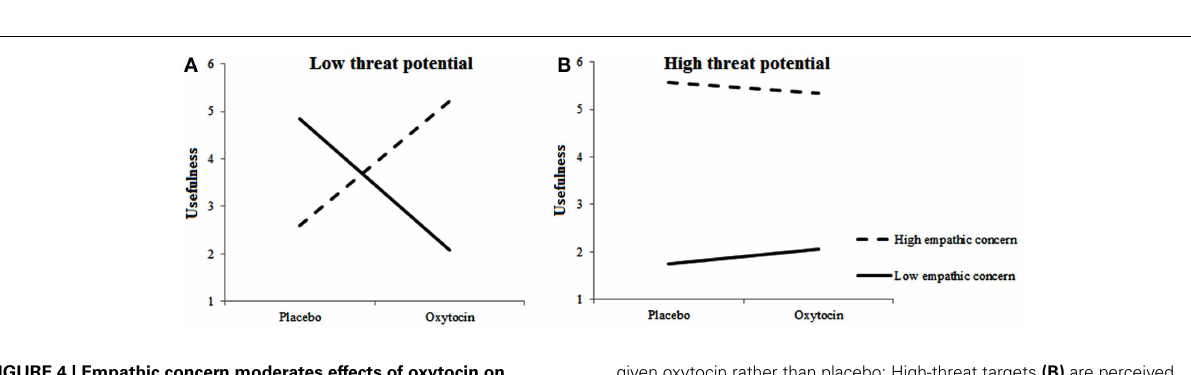
given oxytocin rather than placebo; High-threat targets (B) are perceived as more useful by individuals with high empathic concern regardless of